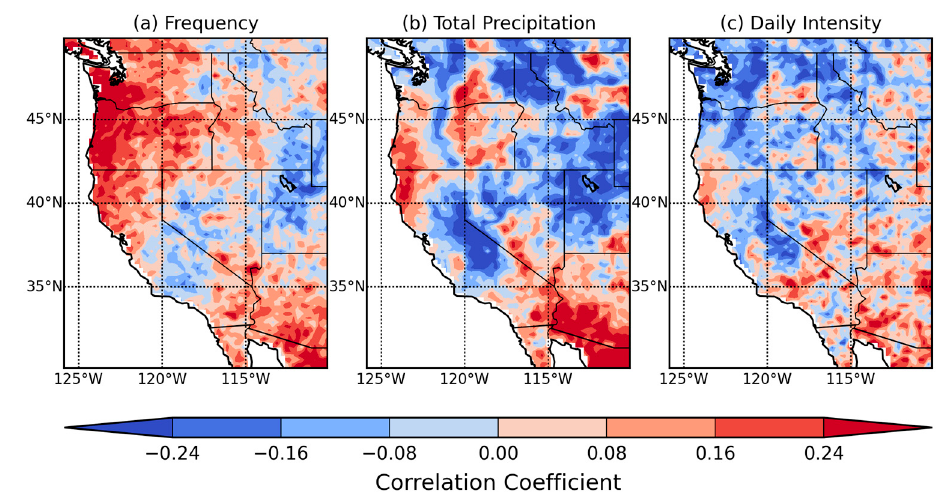
Figure 12. The correlation coefficient between Multivariate ENSO Index (MEI) ENSO Index and winter season precipitation ( a ) frequency, ( b ) seasonal total, and ( c ) mean daily intensity over the western United States between DJF 1999 and 2016. The hatched areas indicate areas of statistical significance.